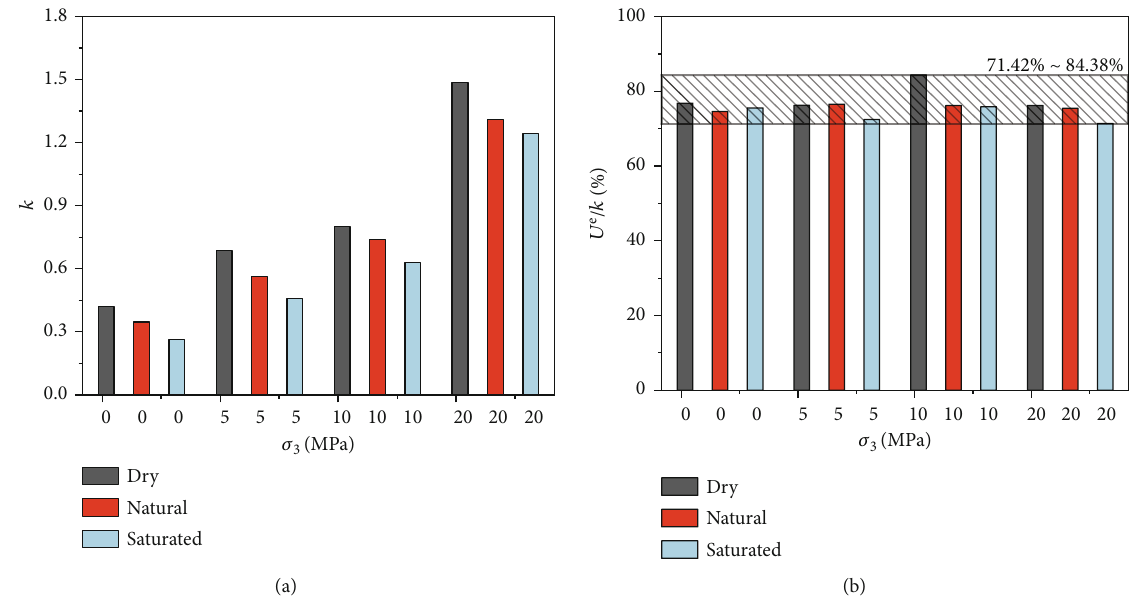
Figure 12: The variation law of parameter k value under di ff erent con fi ning pressure and water content state and its relationship with the energy storage limitation: (a) energy fi tting parameter k values; (b) relationship between parameter k value and energy storage